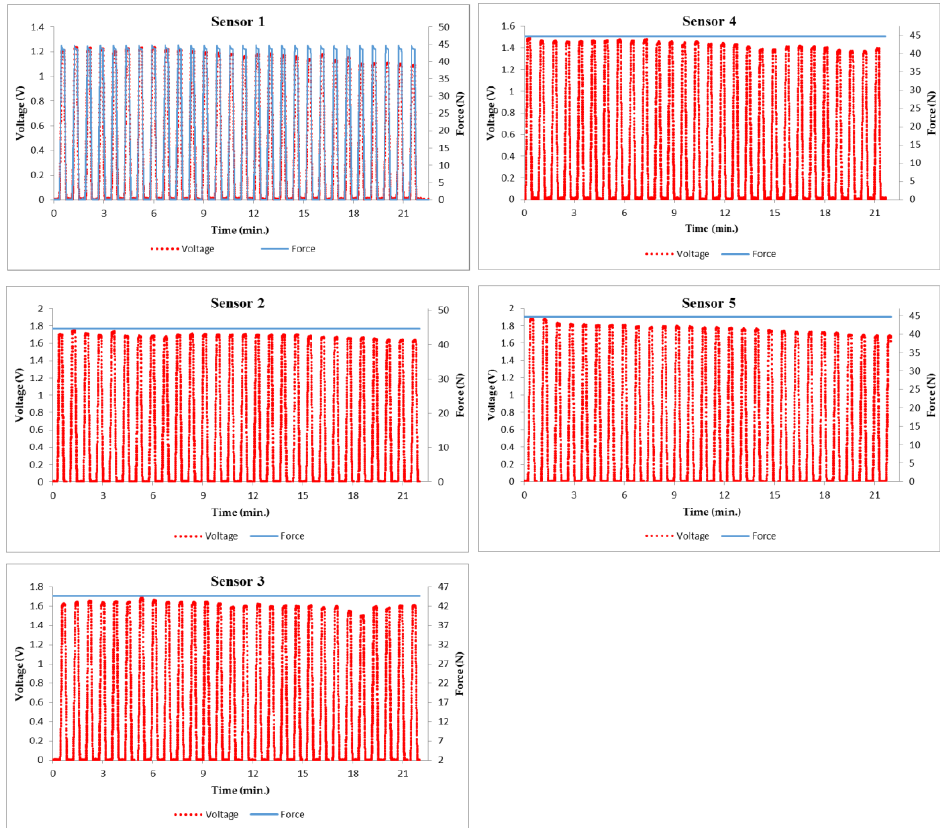
Figure 4. The relative measured voltage change in the sensor over the course of 20 min while applying a dynamic force of 44.13 N (28 repetition cycles, 10 s holding time, 100 Hz sample rate).